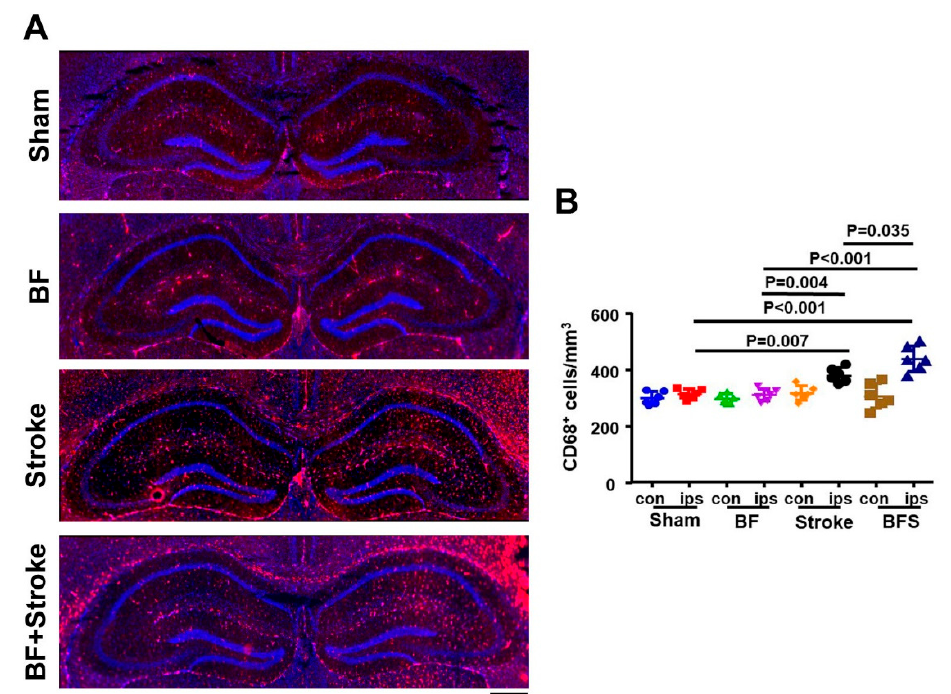
Figure 2. BF increased the amount of CD68 + cells in the ipsilateral hippocampal CA1 region. ( A ). Representative microscopic images of CD68 + antibody (red) stained sections. The nuclei were stained with DAPI (Blue). Scale bar: 500 µm. ( B ). Quantification of the number of CD68 + cells. The groups represented by different colors are indicated on the X-axis. N = 6. con: contralateral to stroke injury. ips: ipsilateral to stroke injury. BFS: BF 6 h before stroke.